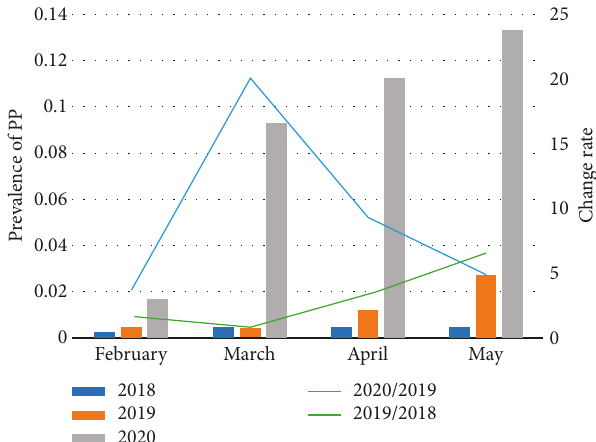
Figure 2: Prevalence and change rate in the number of female cases of new-onset precocious puberty in Henan Children’s Hospital in different time periods with a CR of < 0.5 to identify inhibited diseases and CR of > 3 to identify stimulated diseases (CR � ratio of the prevalence of female cases of new-onset precocious puberty in different time